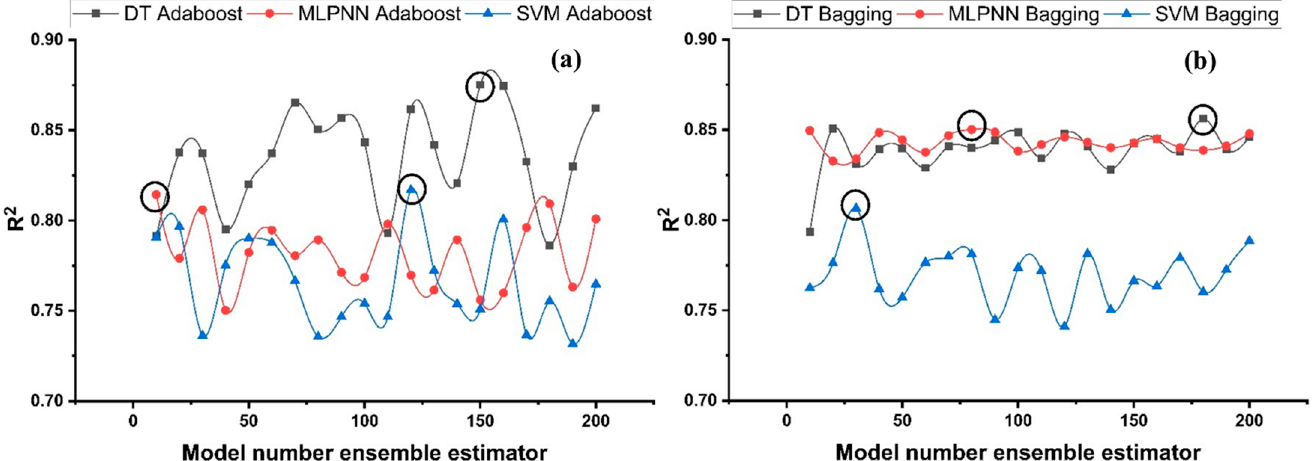
Figure 10. R 2 for compressive strength ensemble models with different sub-models; ( a ) Adaboost; ( b ) Bagging.